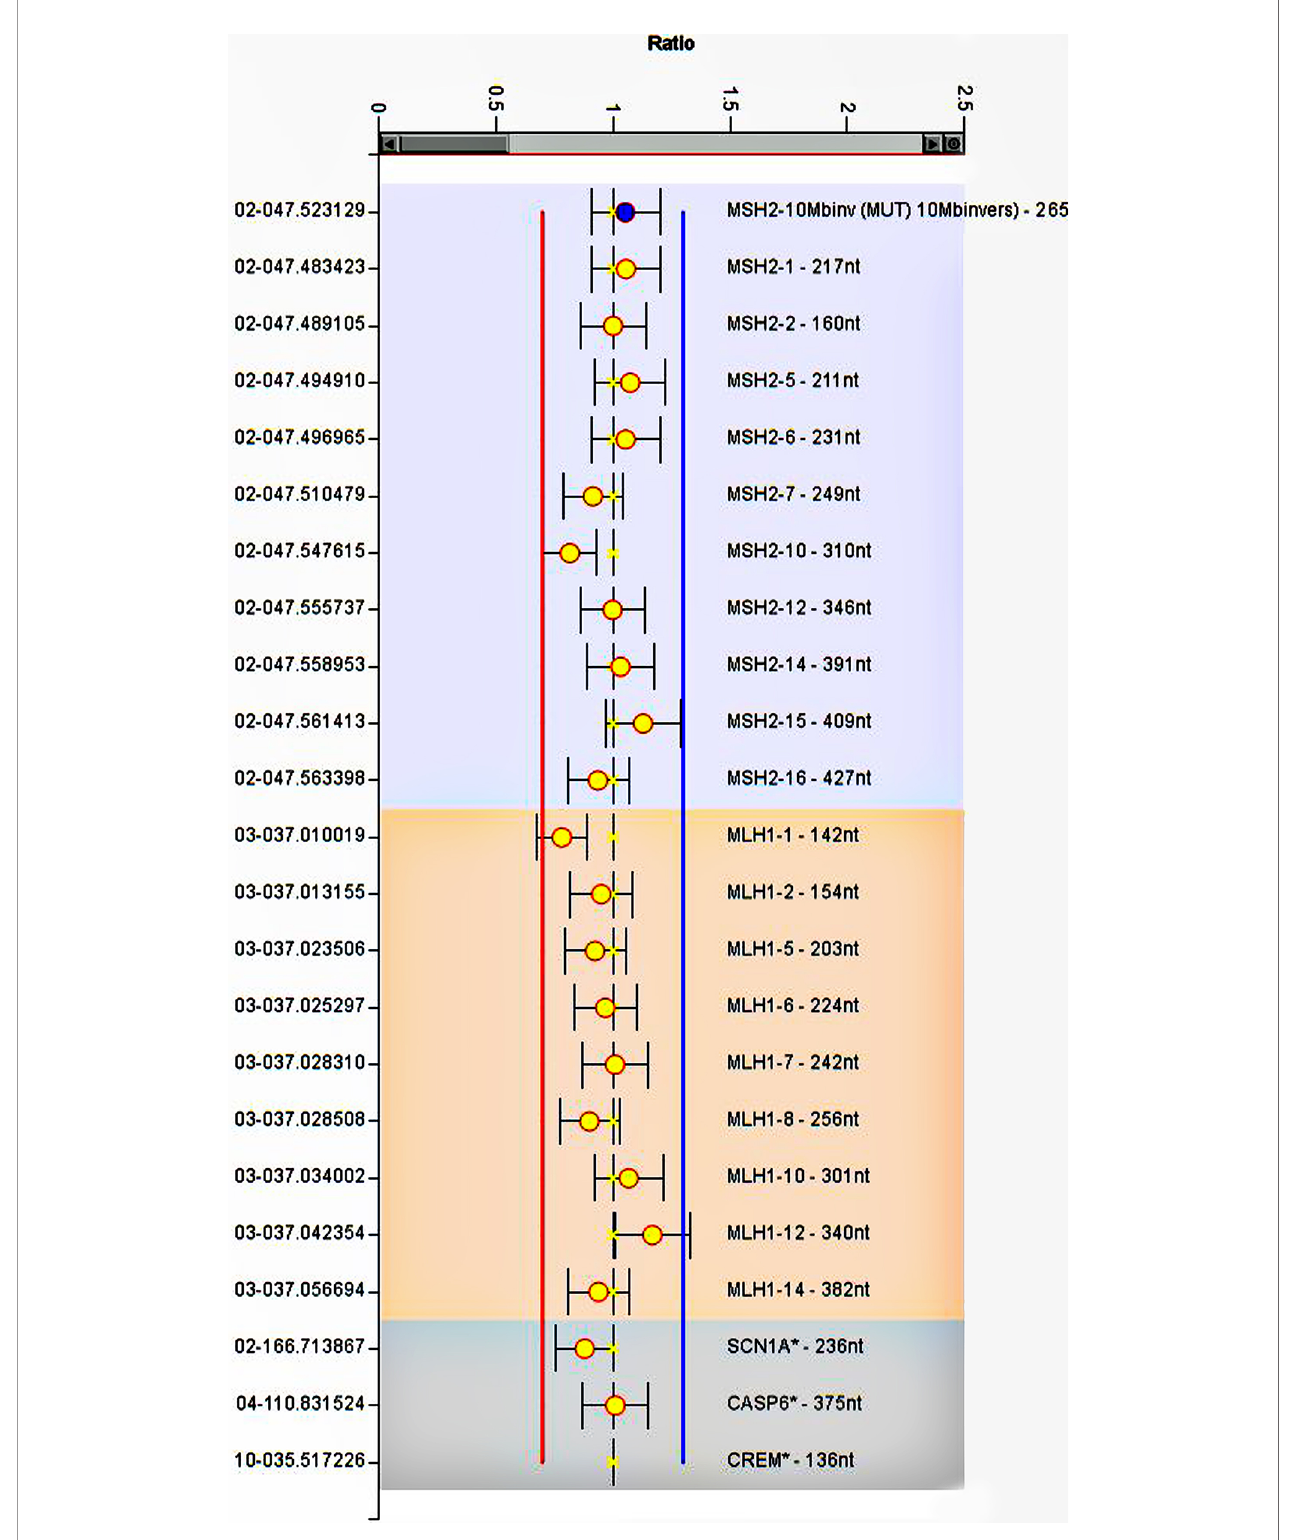
FIGURE 3 | MLPA analysis of MLH1 and MSH2 . The image represents no deletion or duplication at gene regions. The error bars show standard deviation. Ratios of the signals normalized to the control reference individual.